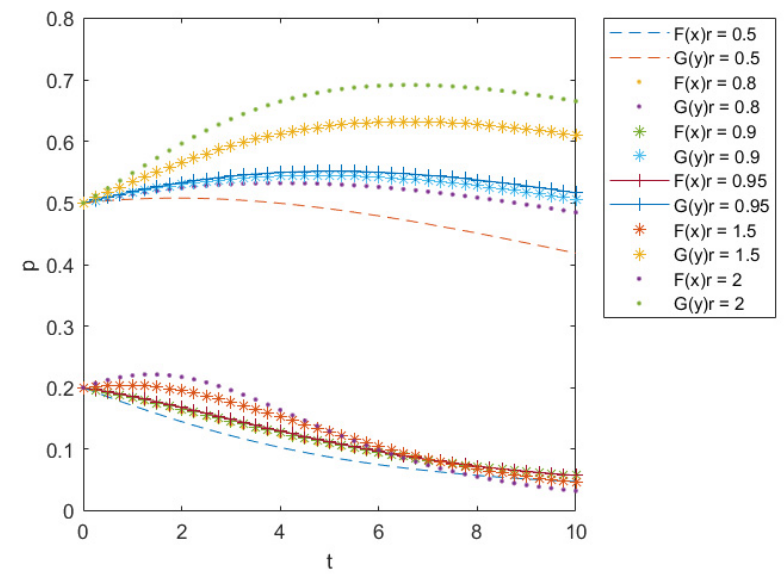
Figure 5. E ff ect of penalty r changes on evolutionary outcomes. Figure 5. Effect of penalty r changes on evolutionary